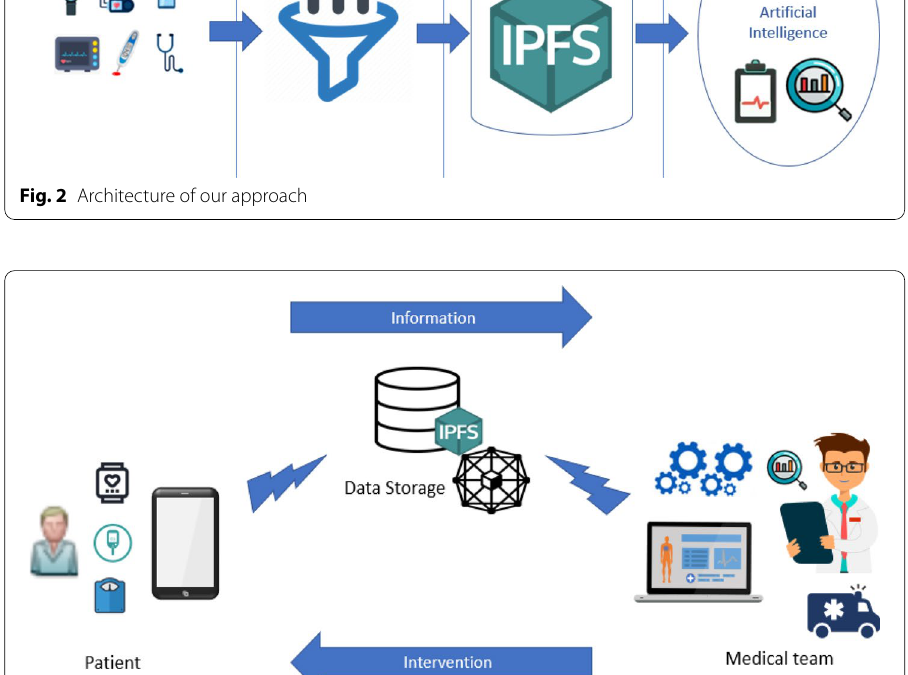
Fig. 3 Patient–Physician interaction: Health data is collected via wearable sensors and sent to the medical team via the patient smartphone. This information is used to predict the patient state from the model, then the medical team will react according to the gravity of the